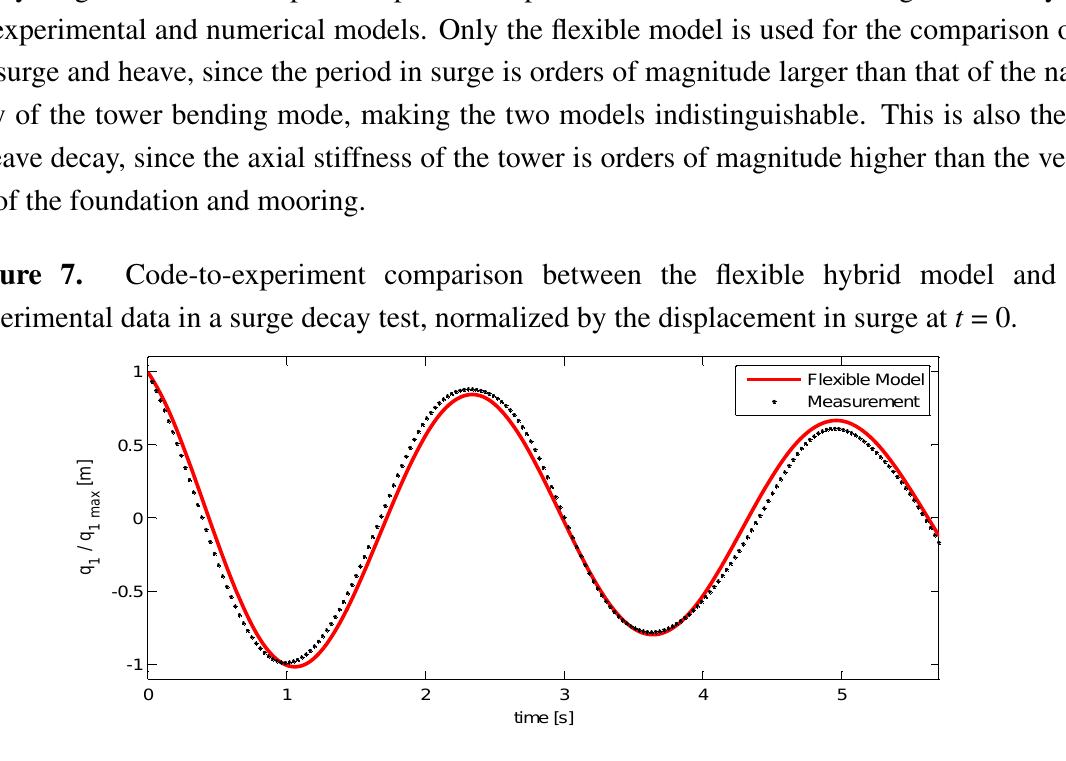
Figure 8. Code-to-experiment comparison between the flexible hybrid model and experimental data in a heave decay test, normalized by the displacement in heave at t = 0.